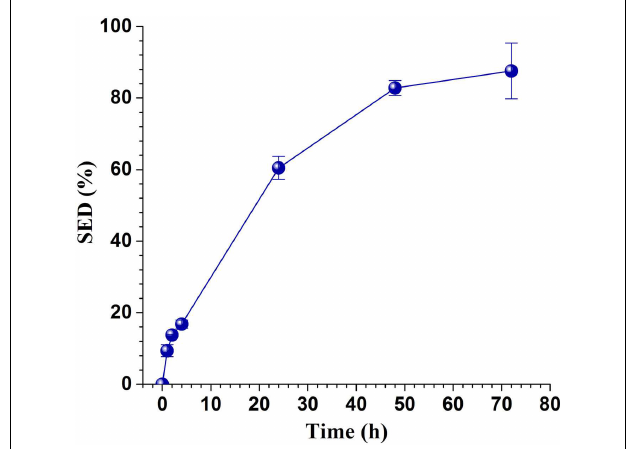
FIGURE 2 |Time-dependent enzymatic saccharification efficiency of the washed solids of SPORL pretreated NE222 at a low CTec3 loading of 10FPUgglucan -1